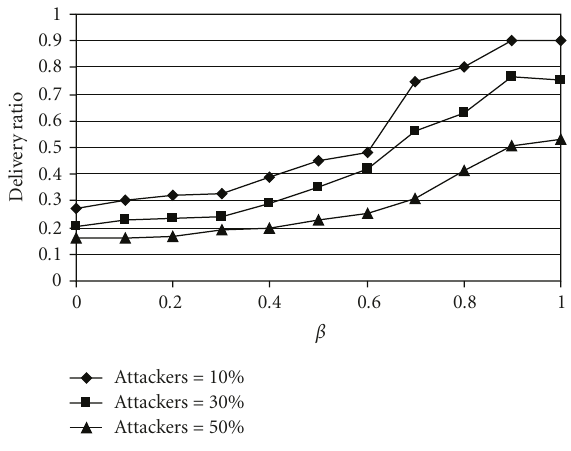
Figure 10: Delivery ratio with various percentages of attackers.